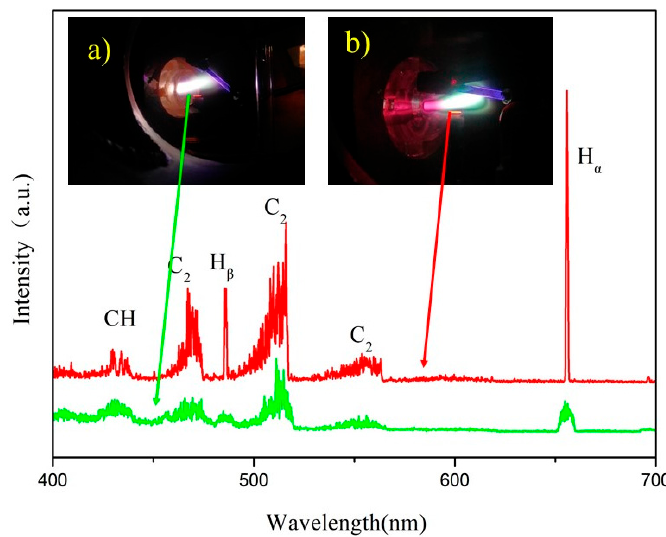
Figure 2. Optical emission spectra and plasma torches under two process conditions: ( a ) old process conditions, ( b ) improved process conditions.